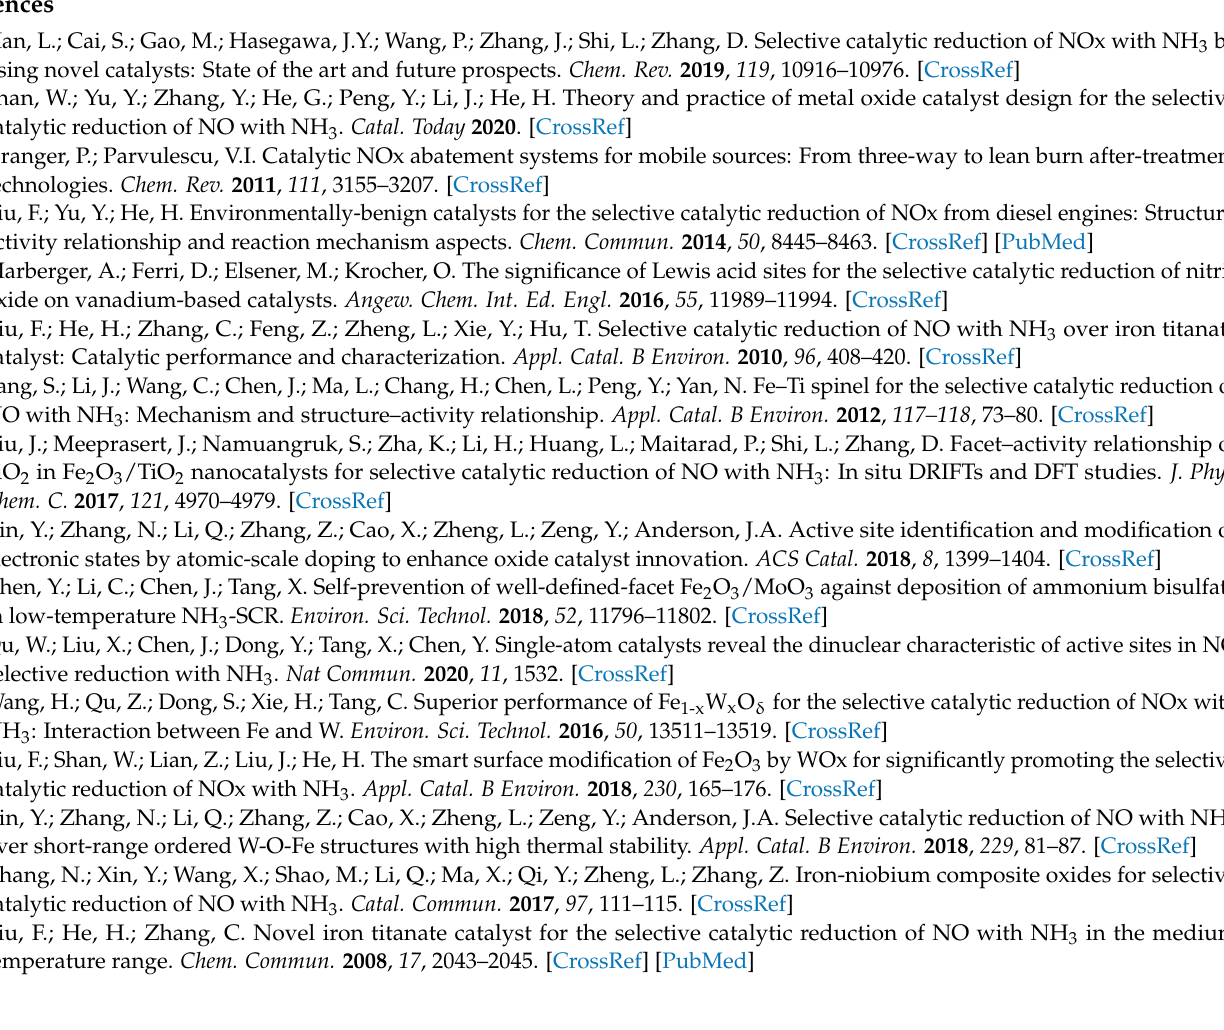
XPS spectra of (a) Nb 3d; (b) Ti 2p; and (c) Mo 3d over FeM 0.3 O x -C and FeM 0.3 O x (M = Nb, Ti, Mo) samples, Figure S5: XPS spectra of Fe 2p over FeM 0.3 O x -C and FeM 0.3 O x (M = Nb, Ti, Mo) samples, Figure S6: Direct oxidation of NH 3 over all the samples. Reaction conditions: [NH 3 ] = 500 ppm, [O 2 ] = 5 vol %, N 2 balance, GHSV = 250,000 h − 1 , Figure S7: Direct oxidation of NO over all the samples. Reaction conditions: [NO] = 500 ppm, [O 2 ] = 5 vol %, N 2 balance, GHSV = 250,000 h − 1 , Figure S8: NO x conversion over pure γ -Fe 2 O 3 and pure α -Fe 2 O 3 . Reaction conditions: [NO] = [NH 3 ] = 500 ppm, [O 2 ] = 5 vol %, N 2 balance, GHSV = 500,000 h − 1 , Table S1: Isomer shift (mm s − 1